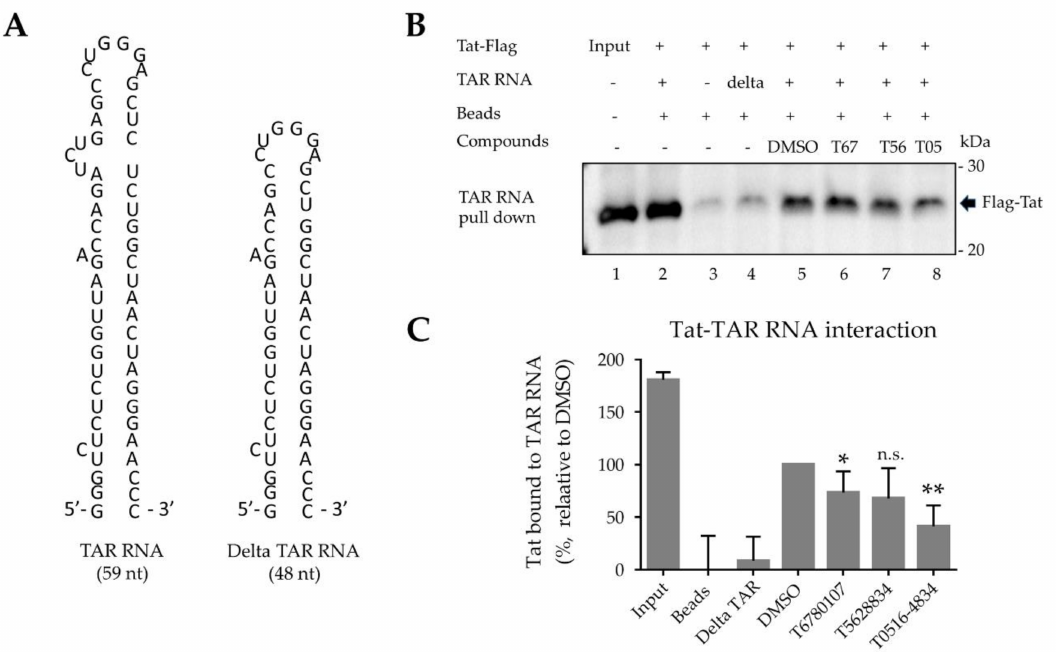
Figure 4. Disruption of Tat–TAR RNA interaction by T0516-4834 compound. ( A ) Structures of TAR RNA and bulge-deleted (delta) TAR RNA. ( B , C ) Immunoblotting of Tat bound to TAR RNA. Tat and TAR RNA binding was performed using protein lysate prepared from 293T cells expressing Flag-Tat and biotinylated TAR RNA coupled to agarose beads. Where indicated, the incubation mixture was supplemented with 10 µ M of the indicated compound. Tat protein was eluted from the beads with SDS loading buffer, resolved on SDS-PAGE and detected with anti-Flag antibody. ( C ) Quantification of Tat protein bound to TAR RNA. Shown are results from three independent experiments that were plotted using Prism 6. * p = 0.04 and ** p = 0.001 in comparison to the DMSO